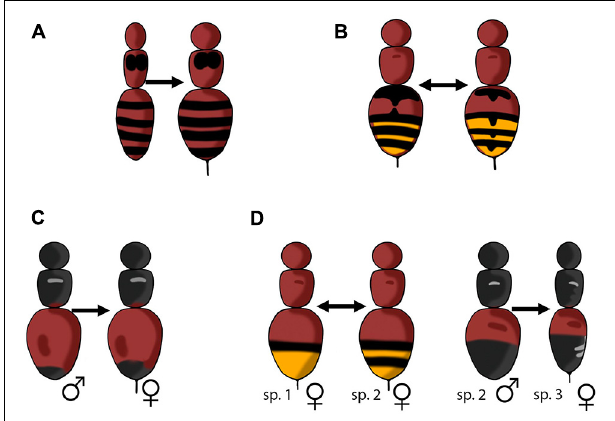
FIGURE 1 | Diagram of the types of mimicry discussed in this review. Arrows represent the direction of selection and point from the mimic to the model, defended model species are indicated by a stinger. (A) Batesian mimicry, an undefended species mimicking a defended model species. (B) Müllerian mimicry, two different defended model species mimic each other. (C) Automimicry, an undefended member of species mimics a defended conspecific model. (D) Dual sex-limited mimicry, a defended female of species 2 is a Müllerian mimic of species 1, an undefended male of species 2 is a Batesian mimic of species 3. Illustration created by Jen